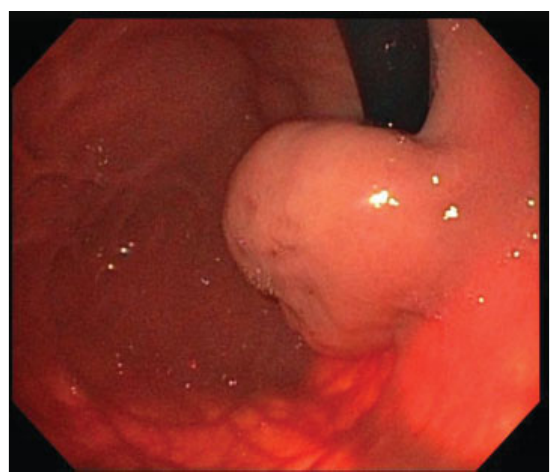
Fig. 1 Photograph taken at the time of endoscopic tumor resection.